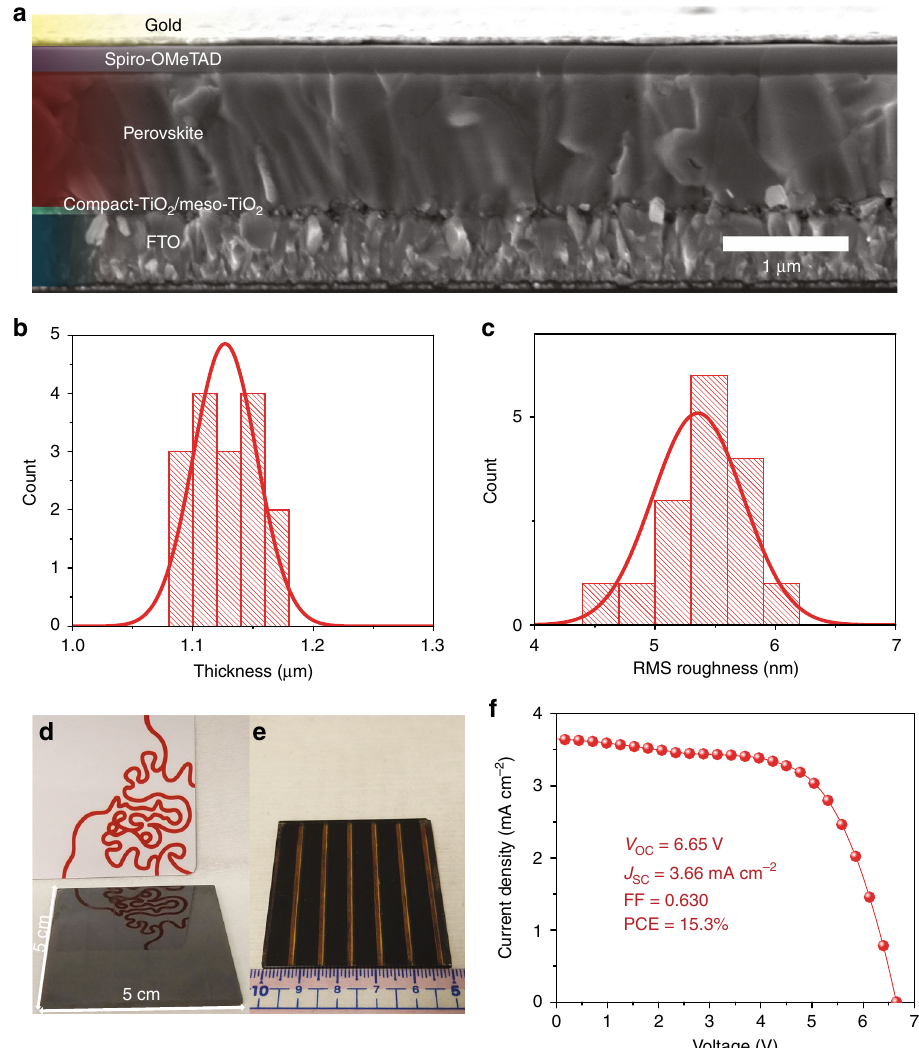
Fig. 4 Solar cells and modules. a Cross-sectional-view SEM image of the PSC based on 1.1- μ m-thick fi lms. b , c Histograms of the thickness and root-mean- square (RMS) roughness of 16 1.1- μ m-thick MAPbI 3 (Cl) samples, respectively. d Photograph of the 1.1- μ m-thick MAPbI 3 (Cl) fi lm on a 5 cm× 5 cm substrate with the mirror-like smooth surface. e Photograph of a 12.0 cm 2 six-cell perovskite solar module fabricated using our new method. f J – V curve of the 5 cm × 5 cm perovskite module with an active area of 12.0 cm 2 based on 1.1- μ m-thick MAPbI 3 (Cl) fi